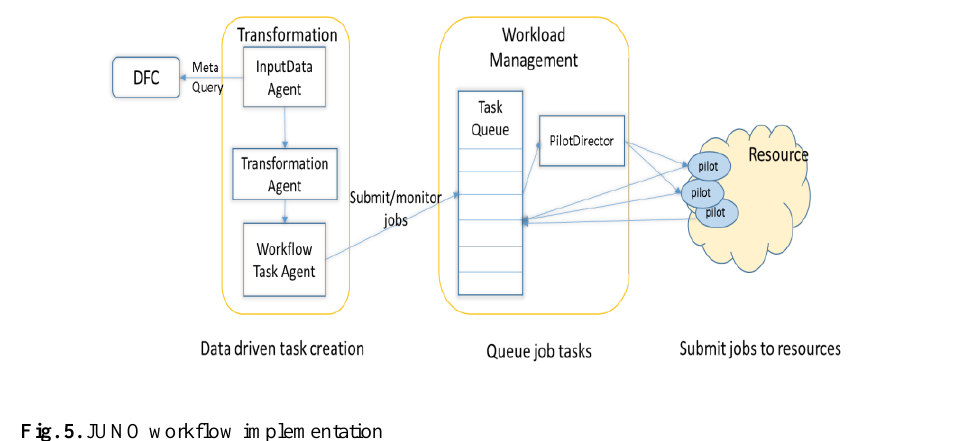
Fig. 5. JUNO workflow implementation